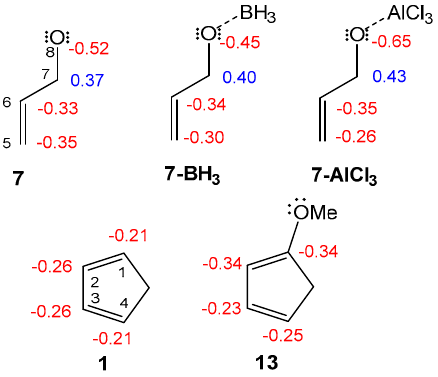
Chart 2. ELF-based Lewis-like structures and natural atomic charges. Negative charges are colored in red and positive charges are colored in blue. ELF valence basin populations and natural atomic charges are given in average number of electrons, e.